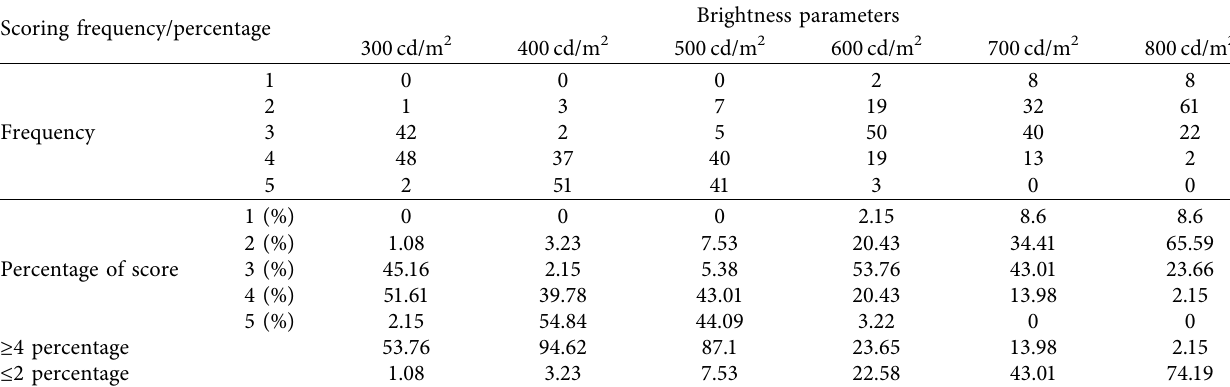
Table 3: Statistical table of visual comfort data frequency percentage.